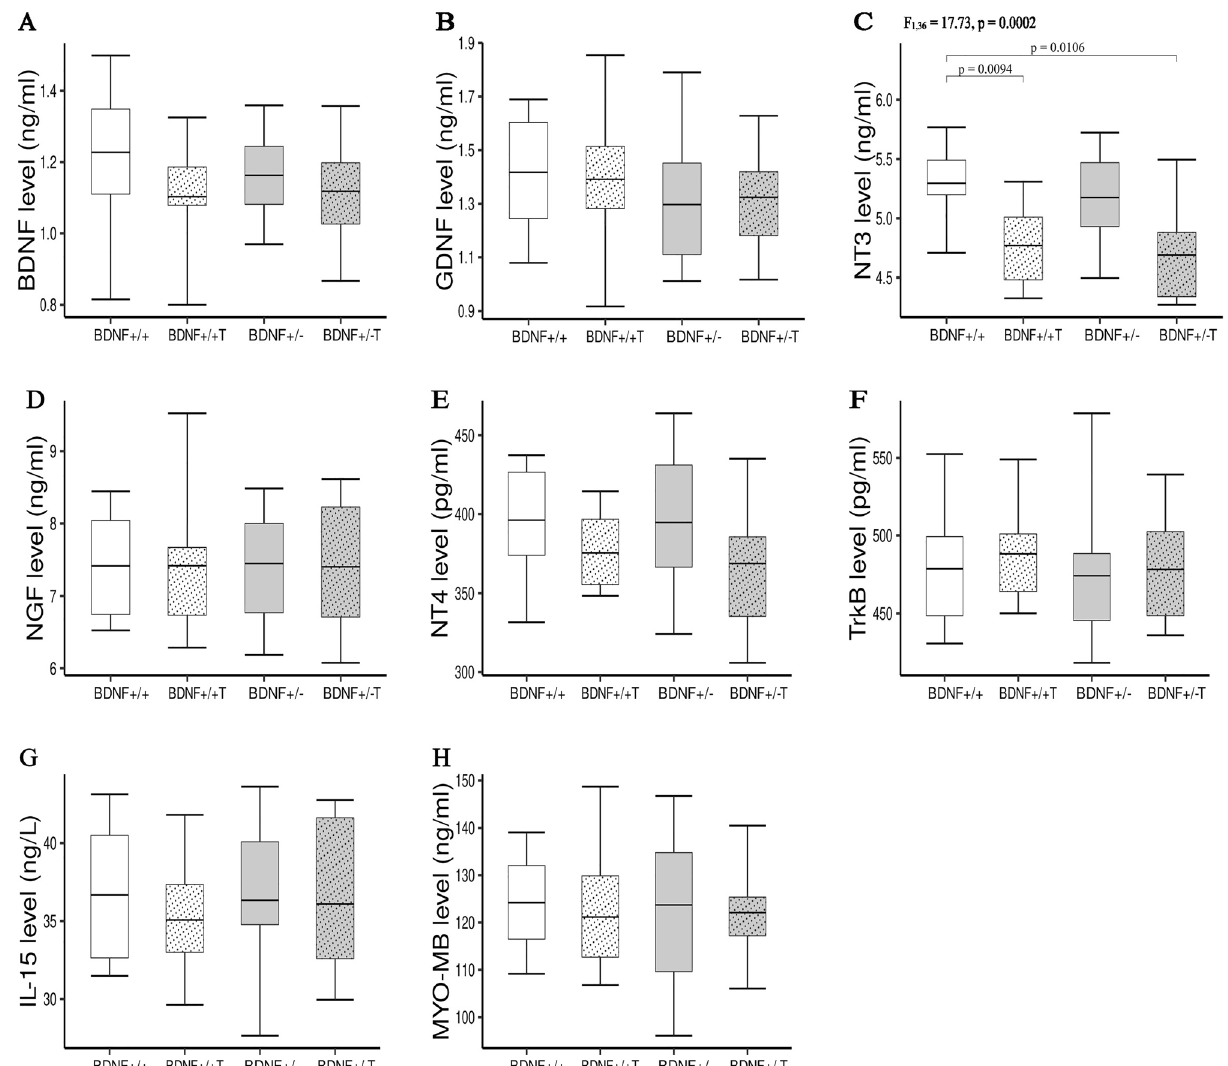
Figure 4. The concentrations of BDNF ( A ), GDNF ( B ), NT3 ( C ), NGF ( D ), NT4 ( E ), TrkB ( F ), IL-15 ( G ), MYO-MB ( H ) in soleus muscles of Bdnf +/+, Bdnf +/+ T, Bdnf +/−, and Bdnf +/− T rats. The bars indicate the mean values, box-plots ± 25% of the dataset, and whiskers ± SD. Differences between the Bdnf +/+ and Bdnf +/− animals, as well as between the Bdnf +/+ T and Bdnf +/− T groups are indicated above the plots (two-way ANOVA with genotype and training as fixed factors with Tukey’s HSD post-hoc